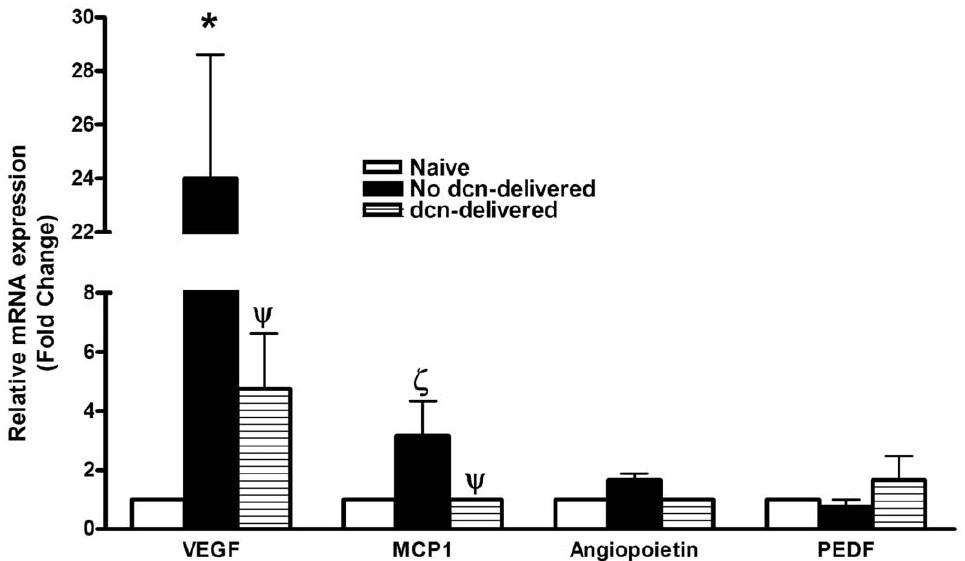
Figure 7. Quantification of mRNA expression of pro- and anti-angiogenic genes by real-time PCR. Real-time PCR was carried out in naive, control (no decorin-delivered) and decorin-delivered rabbit corneal tissues collected 14 days after VEGF implantation. Decorin gene therapy delivered with AAV5 showed marked decrease in the mRNA expression of VEGF and MCP-1 and less pronounced alteration in angiopoietin and PEDF genes. Our data suggests anti-angiogenic effects of decorin gene therapy are mediated by the down-regulation of pro-angiogeneic (VEGF, MCP1 and angiopoietin) and up-regulation of anti-angiogenic (PEDF) genes. *=p , 0.001 compared to naive; f =p , 0.05 compared to naive; y =p , 0.05 compared to no decorin (dcn)-delivered.